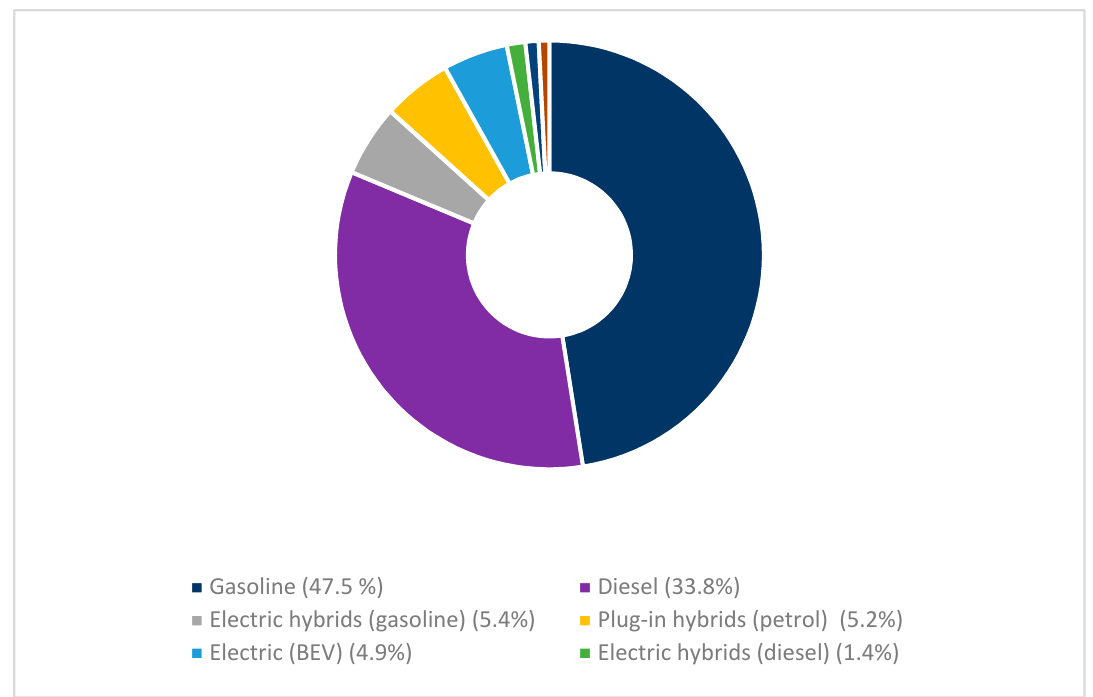
Figure 7. Vehicle market by type of energy in Portugal, 2020 (Source: ACAP Statistics) [27].